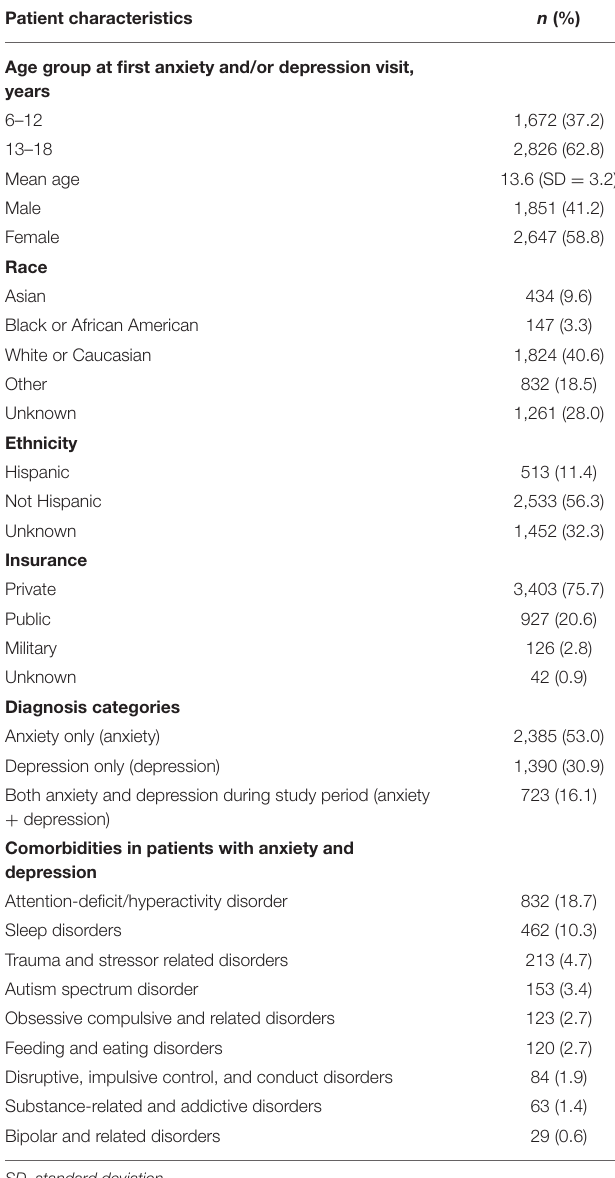
TABLE 1 | Characteristics of patients with anxiety and depression diagnoses ( N = 4,498). Patient